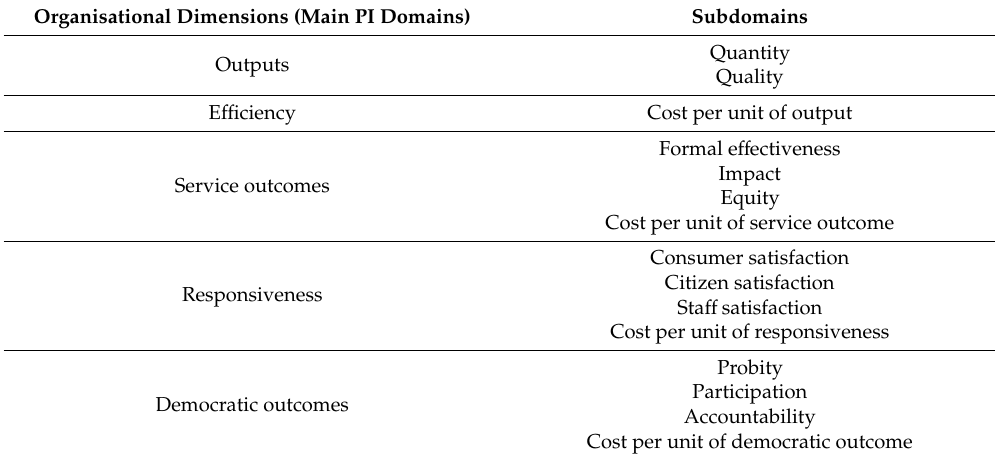
Table 2. Dimensions of organisational performance in local